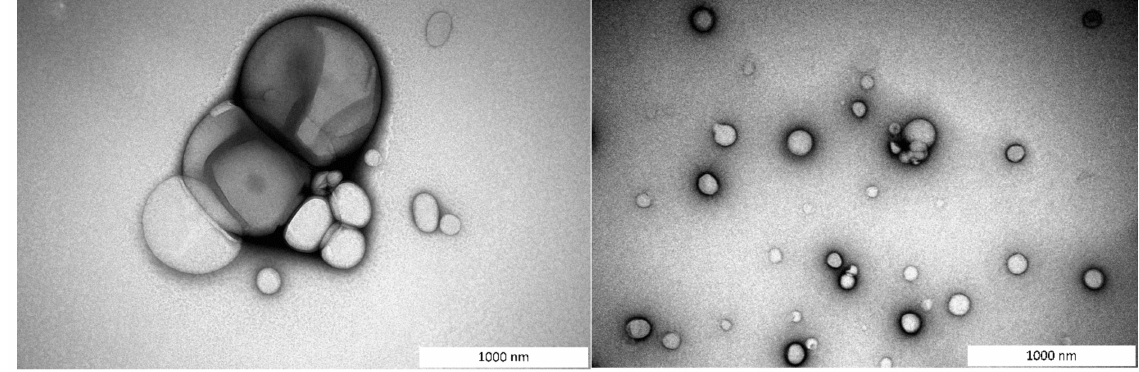
Figure 2. TEM pictures of VANKA loaded liposomes.